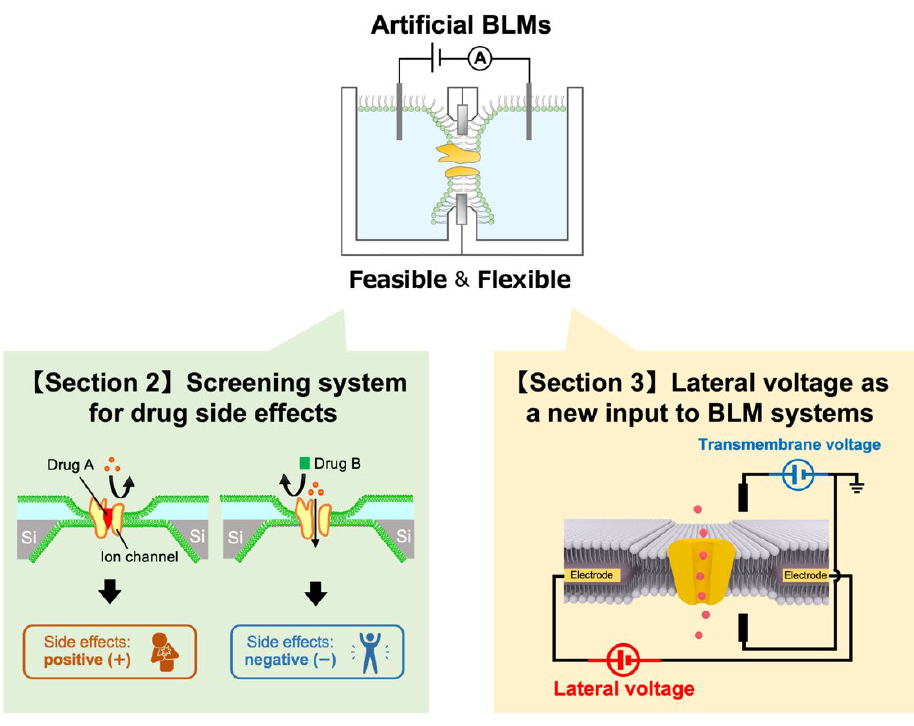
Figure 1. Two systems for ion channel analysis based on bilayer lipid membranes (BLMs).